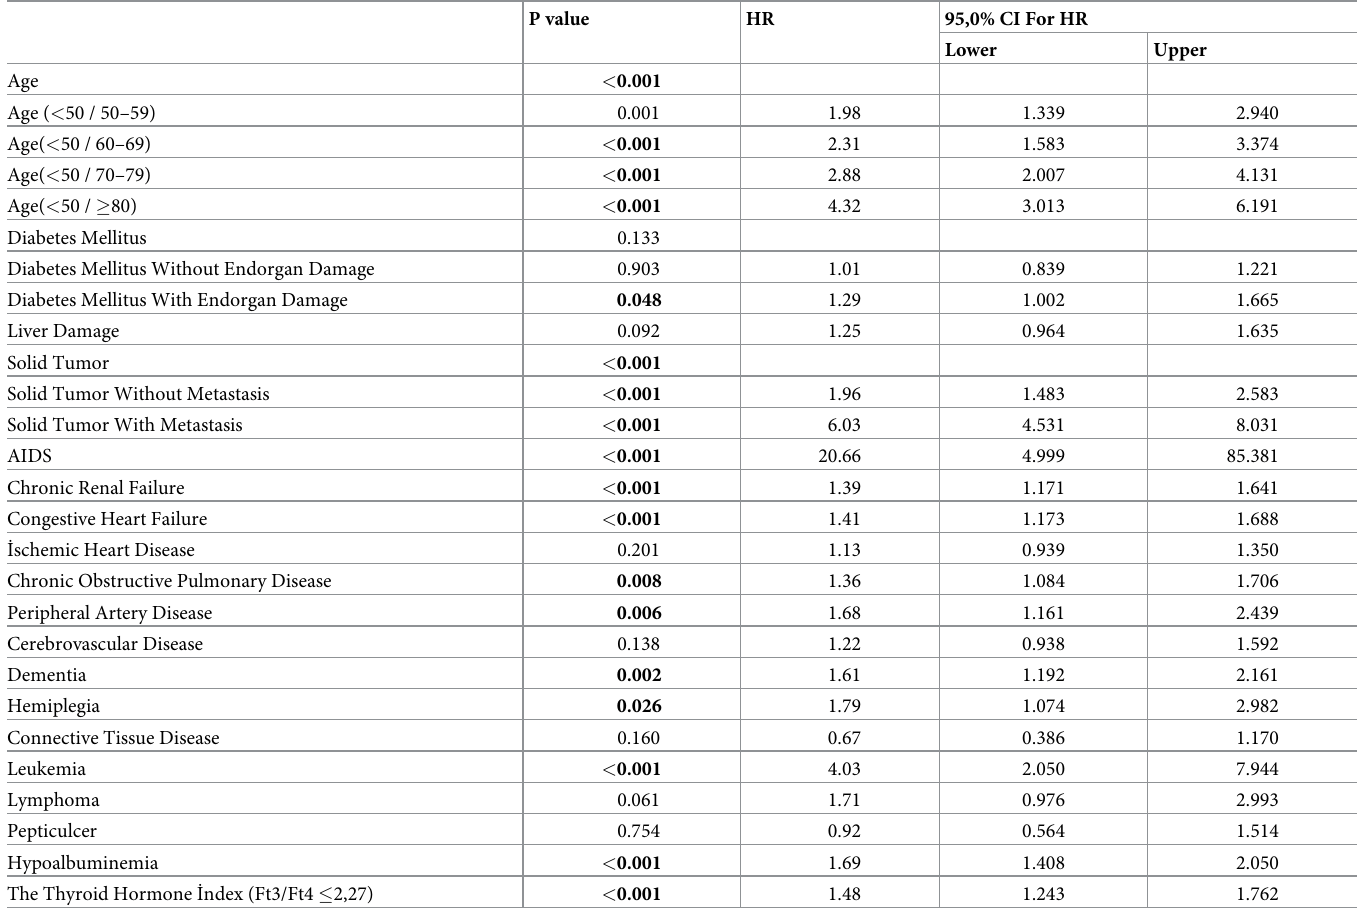
Table 4. Cox regression of comorbidities, albumin and thyroid hormone index in 5 year